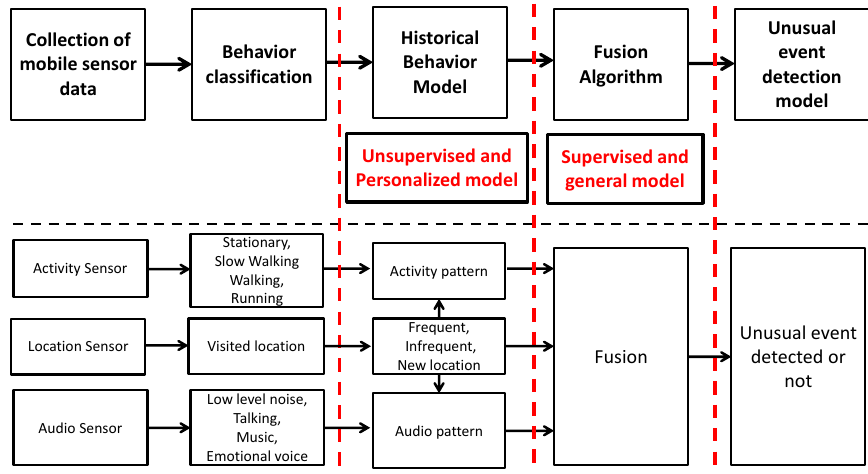
Figure 1. Process for building an unusual event detection model using mobile sensor